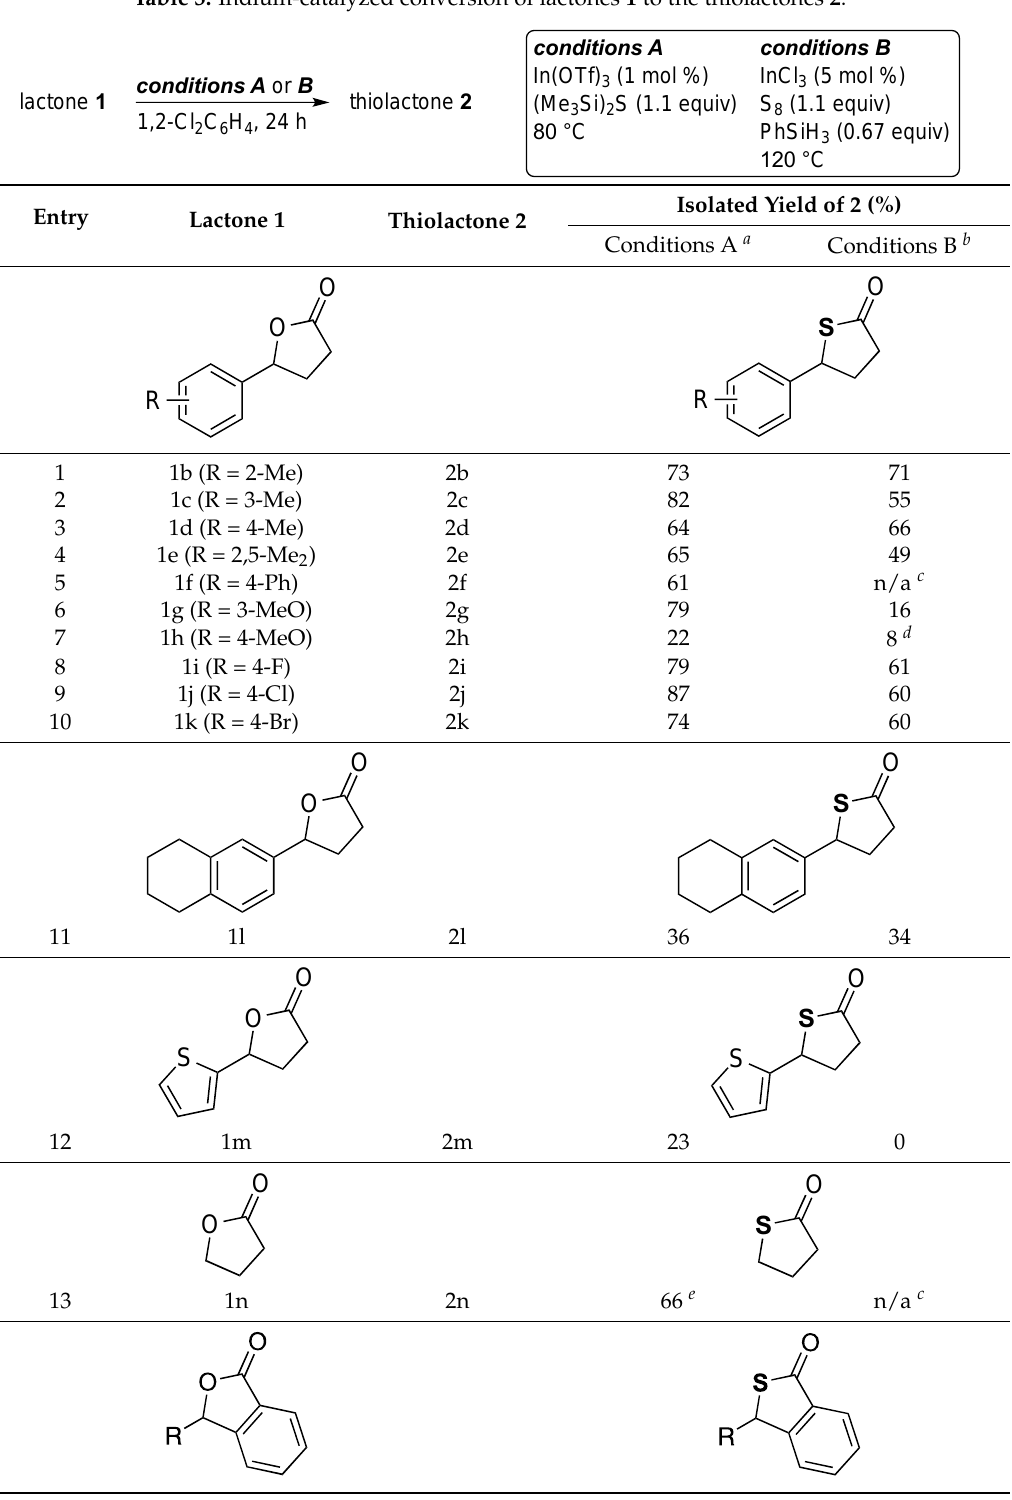
Table 3. Indium-catalyzed conversion of lactones 1 to the thiolactones 2 .